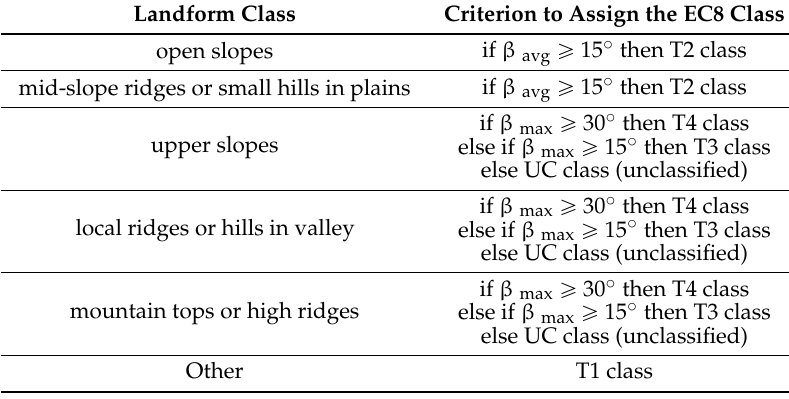
Table 6. Criteria to assess the topographic amplification class following the EC8